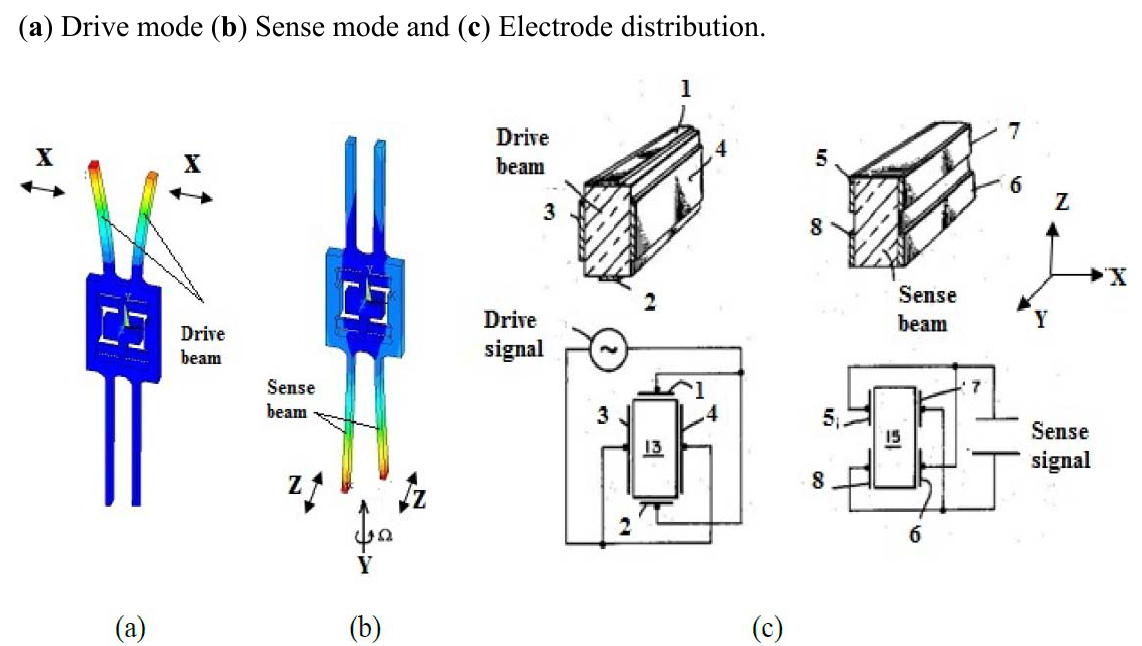
Figure 1. Vibration modes and electrode distribution of a traditional